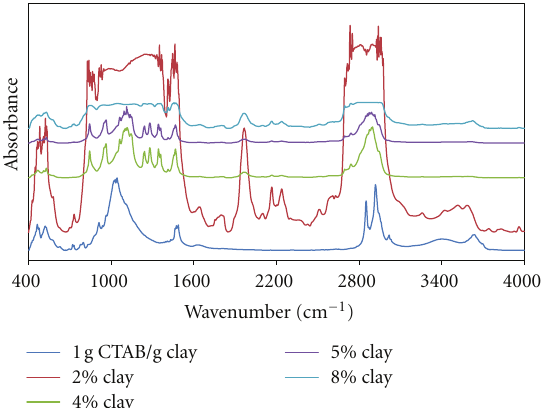
Figure 13: The change of tensile strength of produced PEO/clay nanocomposites at various CTAB/clay ratios with organo-clay